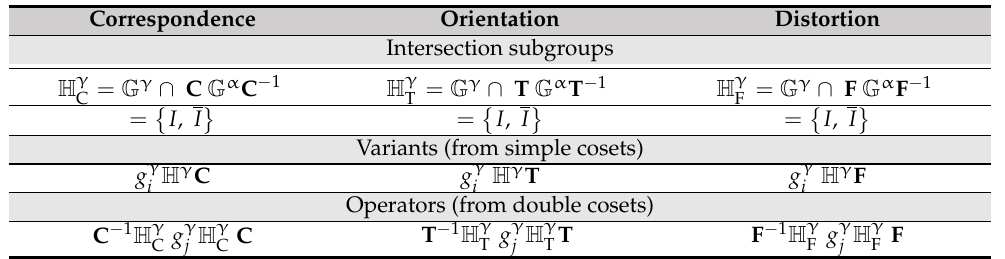
Table A1. Intersection group, variants and operators in the 2D case of a square ( γ ) to the parallelogram ( α ) transformation of correspondence, orientation and distortion types of